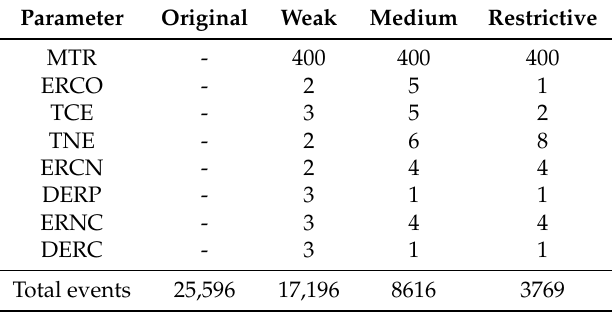
Table 1. Parameter values for different LDSI filter configuration and the associated number of events generated for the image shown in Figure 11. The original number of events from source with no filtering is also